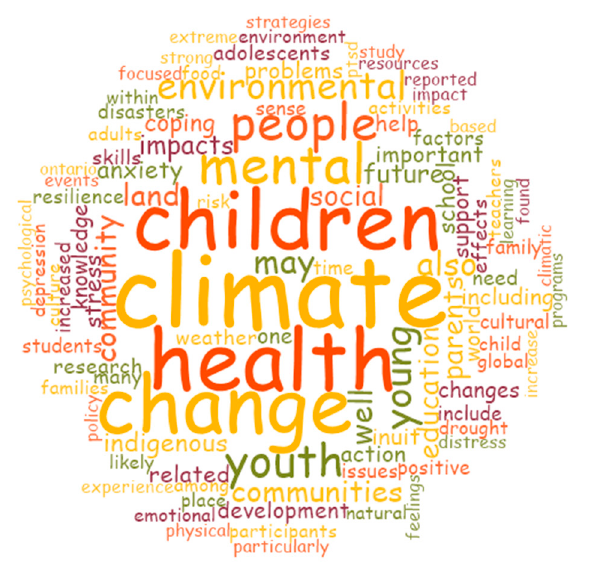
Figure 5. Word cloud of most frequent words in the articles included in the analysis.